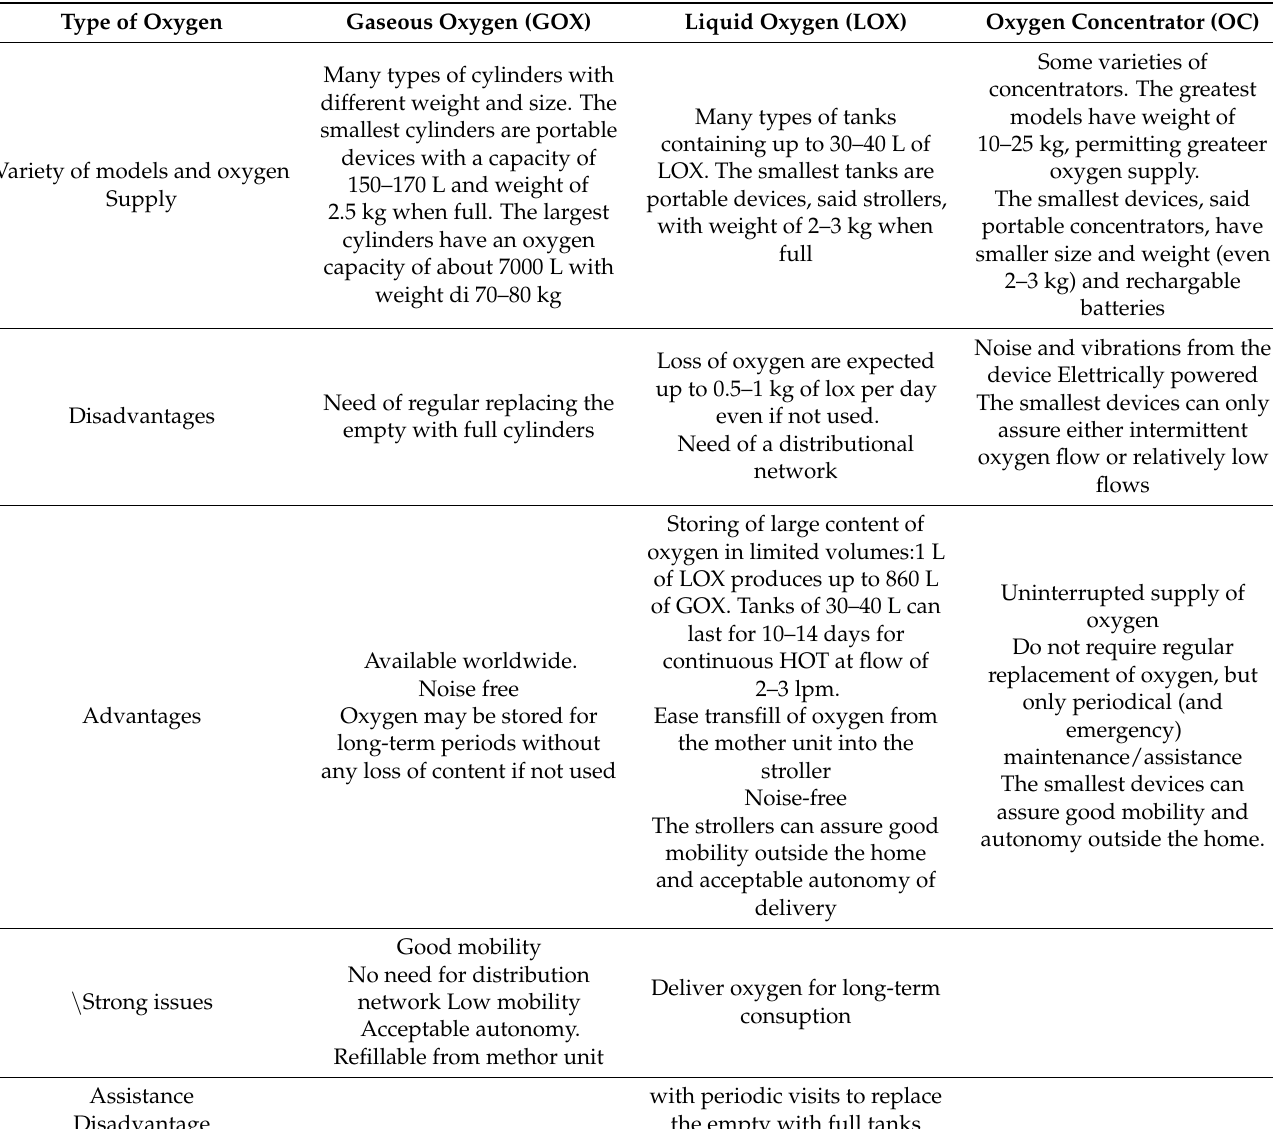
Table A1. Main characteristics of the oxygen sources for HOT in the stable